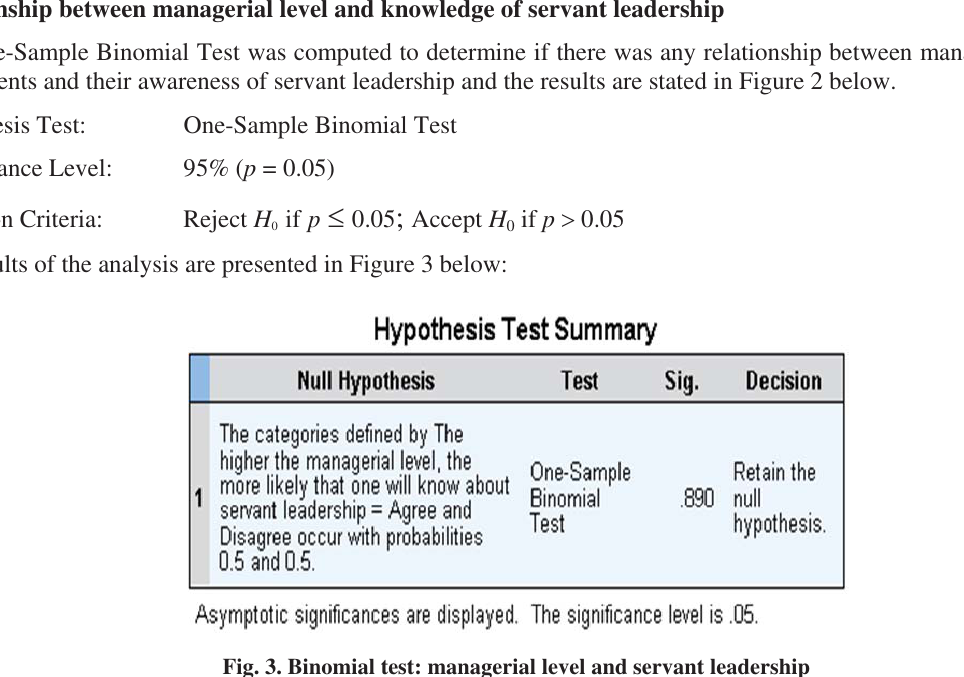
Fig. 3. Binomial test: managerial level and servant leadership